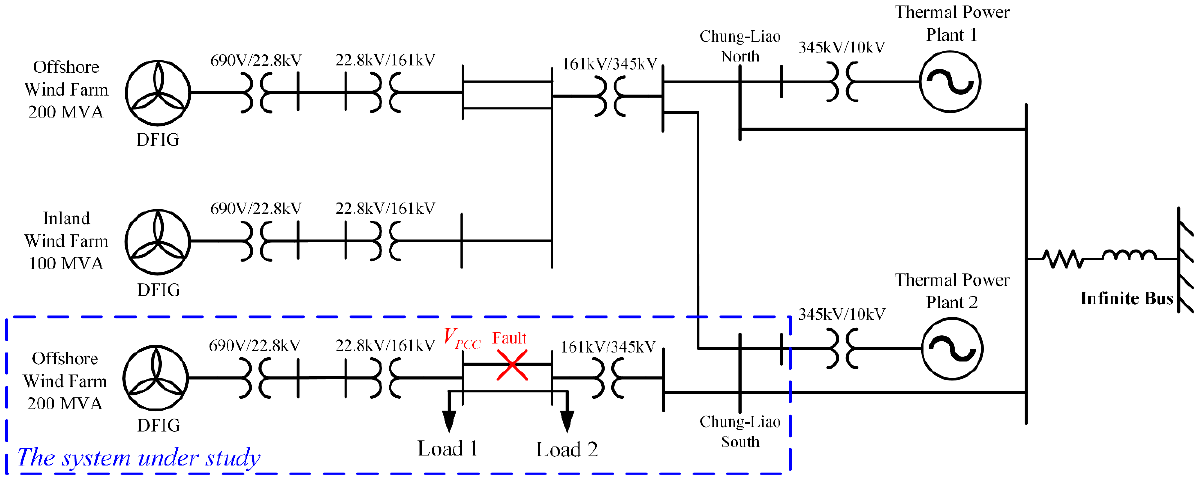
Figure 1. An offshore wind farm connected to the utility grid in central Taiwan. The real and reactive power outputs of the wind farm are controlled by the RSC. By